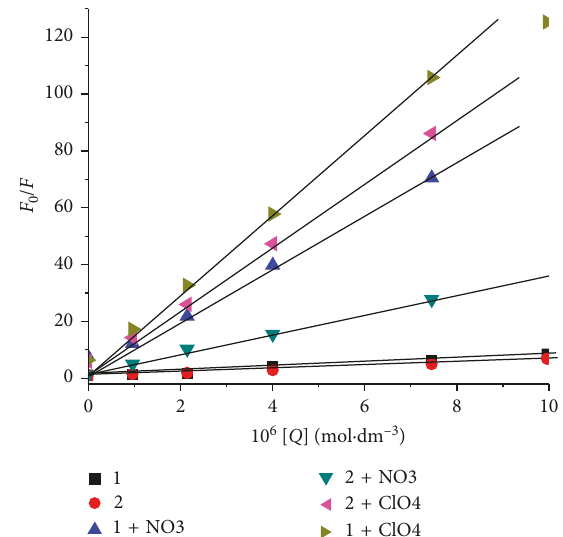
Figure 6: Stern–Volmer plot of HSA fluorescence quenching by ( 1 ) [Ag(I)(Hnor) 2 ]ClO 4 and ( 2 ) [Ag(I)(Hnor) 2 ]NO 3 with additional KClO 4 and KNO 3 at 295nm.